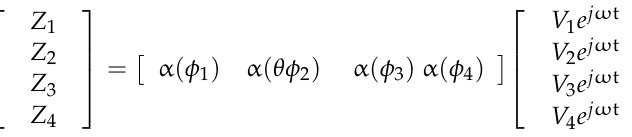
Figure 18. ( a ). Schematic analysis of antenna configuration on the wireless sensor ( b ). CP antenna adaptive analysis of the radiation pattern.